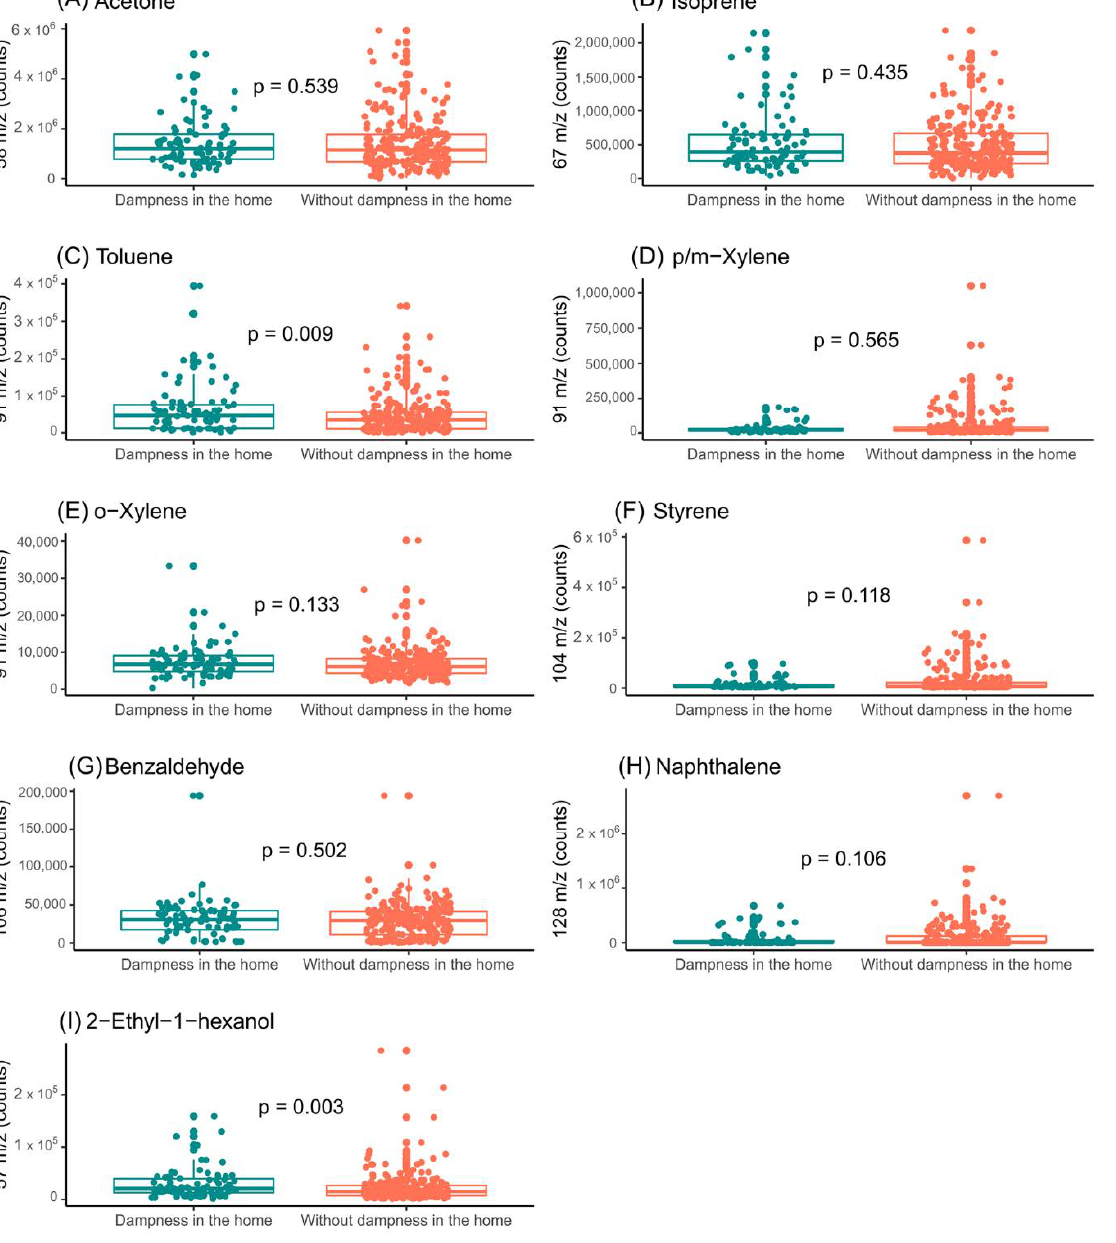
Figure 2. Assessment of indoor-dampness exposure influence on the levels of the features selected in exhaled breath of mothers. ( A ) Impact of indoor-dampness exposure on levels of acetone ( m/z = 58); ( B ) impact of indoor-dampness exposure on levels of isoprene ( m/z = 67); ( C ) impact of indoor-dampness exposure on levels of toluene ( m/z = 91); ( D ) impact of indoor-dampness exposure on levels of p/m-xylene ( m/z = 91); ( E ) impact of indoor-dampness exposure on levels of o-xylene ( m/z = 91); ( f ) impact of indoor-dampness exposure on levels of styrene ( m/z = 104); ( G ) impact of indoor-dampness exposure on levels of benzaldehyde ( m/z = 106); ( H ) impact of indoor-dampness exposure on levels of naphthalene ( m/z = 128); and ( I ) impact of indoor-dampness exposure on levels of 2-ethyl-1-hexanol ( m/z = 57) in exhaled breath of mothers.